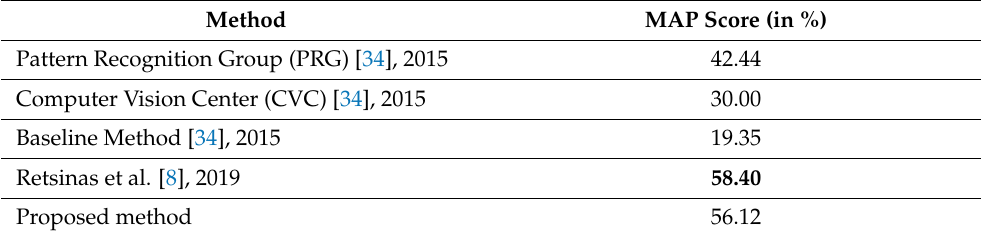
Table 3. Comparative results on the evaluation set of ICDAR2015 competition on KWS for handwrit- ten documents (Track IA) with state-of-the-art methods in terms of the MAP score. The bold faced number represents the best